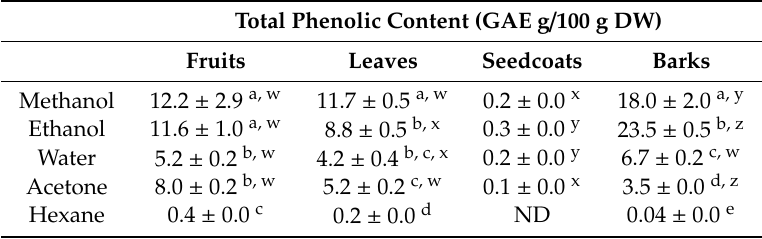
Table 1. Total phenolic contents in T. ferdinandiana